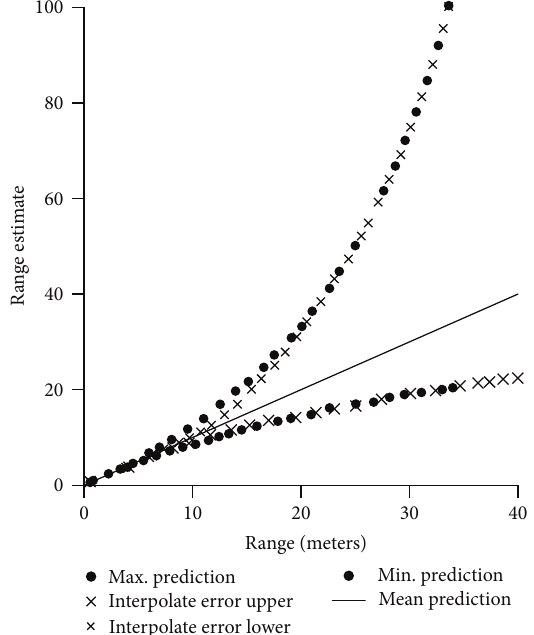
Figure 10: Range error estimates versus range for direct sun. The dashes show maximum and minimum predictions versus